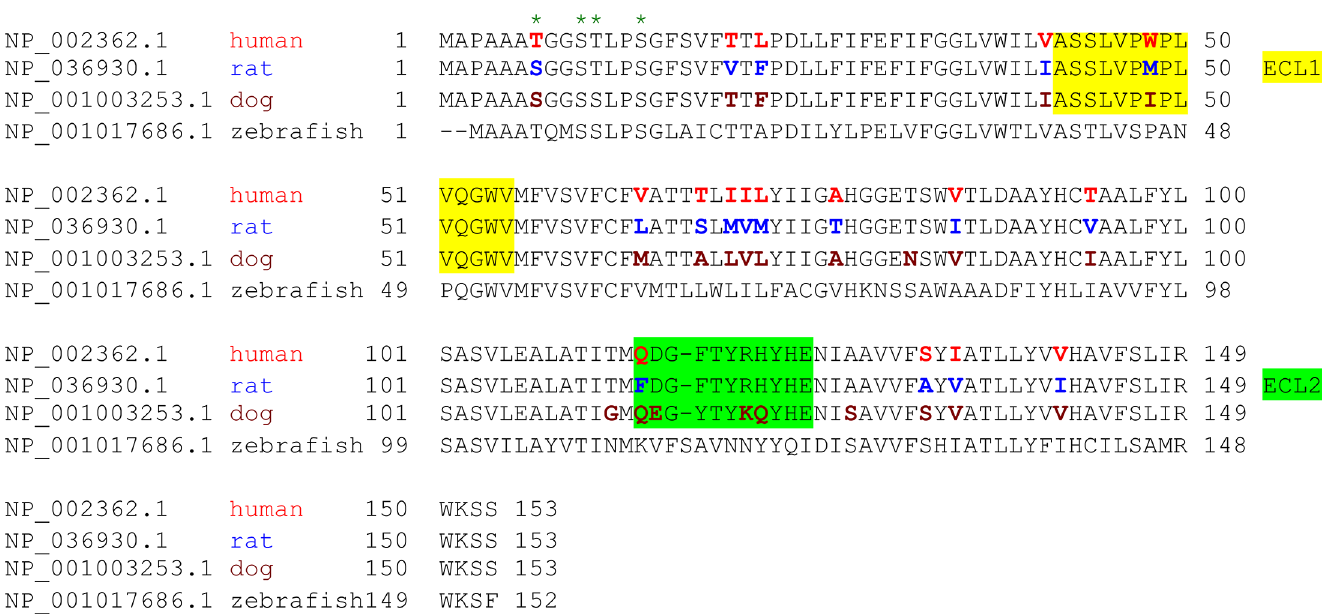
Fig 3. Species variation in the amino acid sequence of MAL. Alignment analysis of human, rat, dog, and zebrafish MAL amino acid (aa) sequences was performed with the multiple sequence alignment program ClustalW2 [100]. The sequence corresponding to the extracellular loop 1 (ECL1) and the extracellular loop 2 (ECL2) is highlighted in yellow and green, respectively. The aa residues differed among human (red), rat (blue), and dog (brown) are